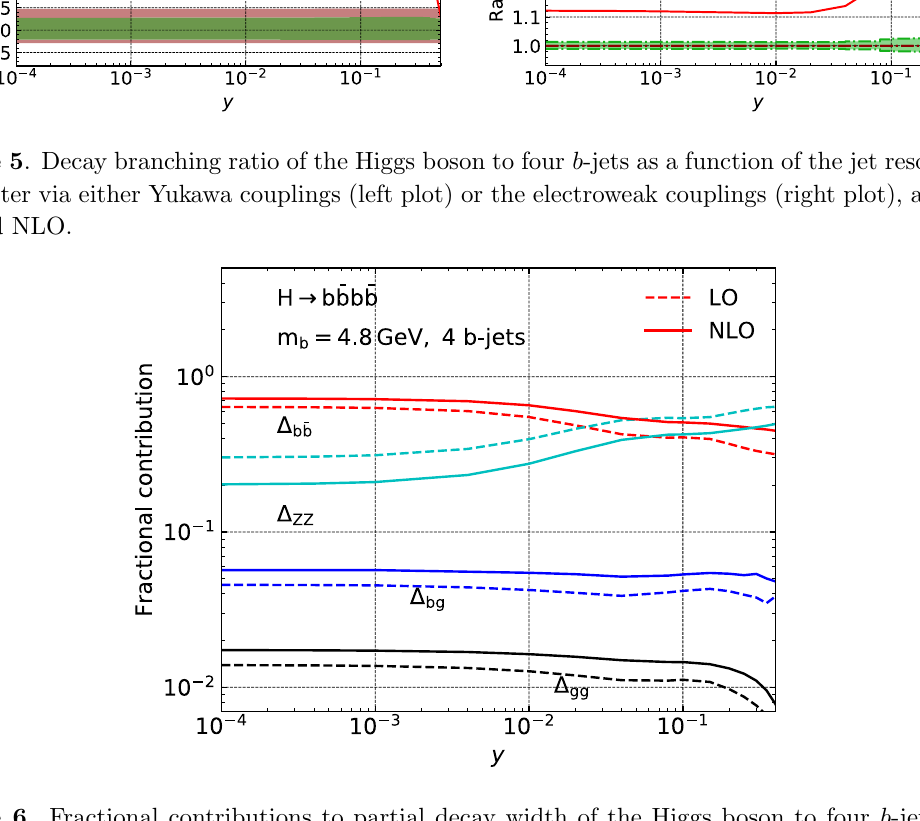
Figure 6 . Fractional contributions to partial decay width of the Higgs boson to four b -jets as a function of the jet resolution parameter, at both LO and